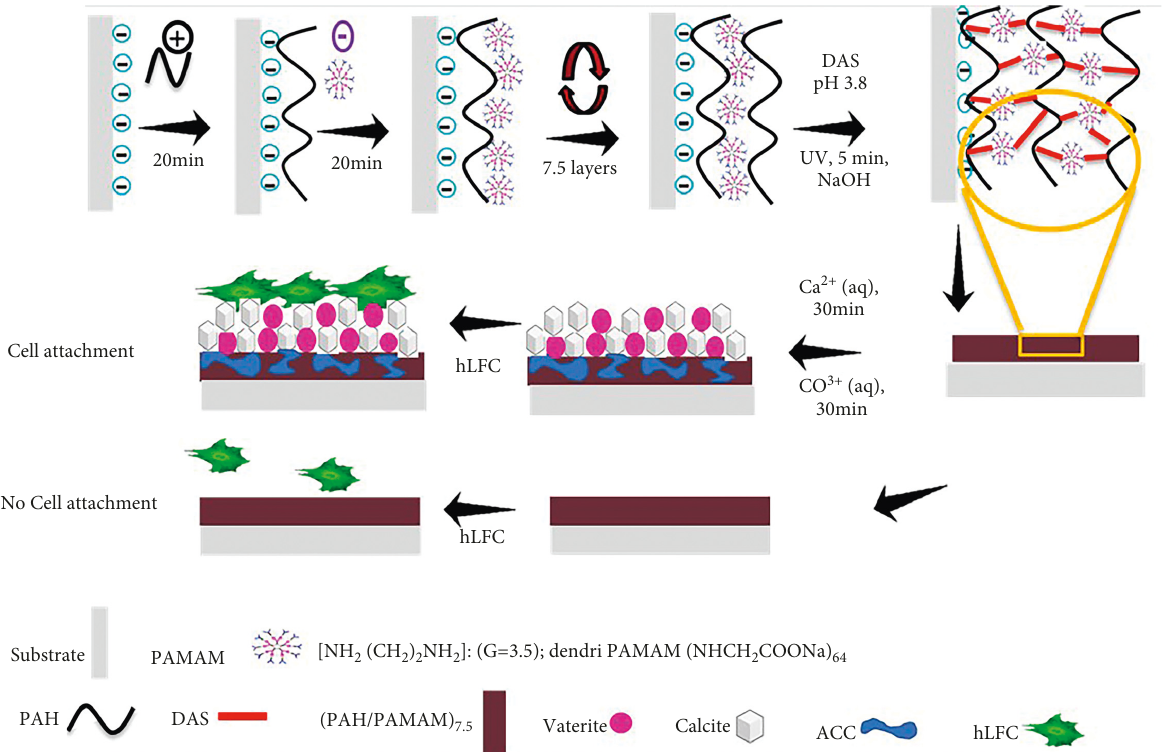
Scheme 1: Schematic diagram of LbL fabrication process of cross-linked (PAH/PAMAM) cell culture using